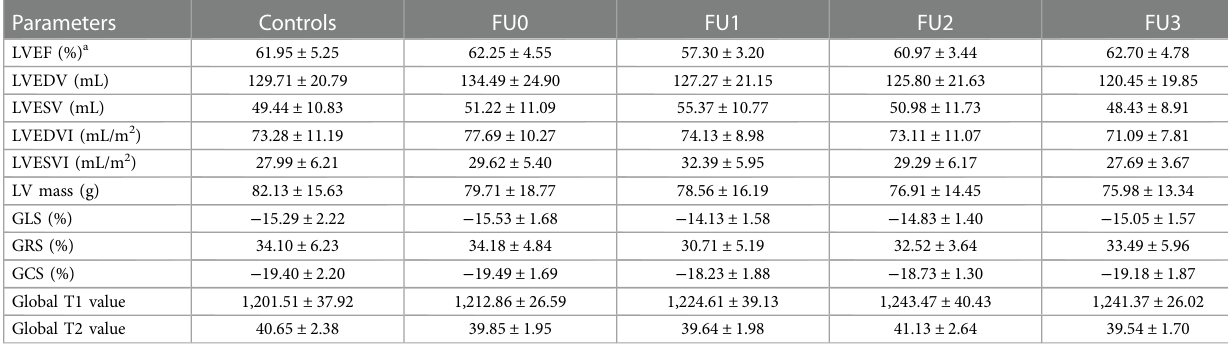
CMR, cardiacmagnetic resonance; LV, leftventricular; LVEF, left ventricleejectionfraction; LVEDV, left ventricularend-diastolic volume;LVESV, leftventricularend-systolic volume; LVEDVI, left ventricular end-diastolic volume index; LVESVI, left ventricular end-systolic volume index; GLS, global longitudinal strain; GCS, global circumferential strain; GRS, global radial strain; FU0, baseline; FU1, 2 days post radiotherapy; FU2, 3 months post radiotherapy; FU3, 6 months post radiotherapy. Unless otherwise speci fi ed, data are mean±SD. Data were compared among baseline and follow-ups by using the Friedman rank test with post-hoc test with Bonferroni